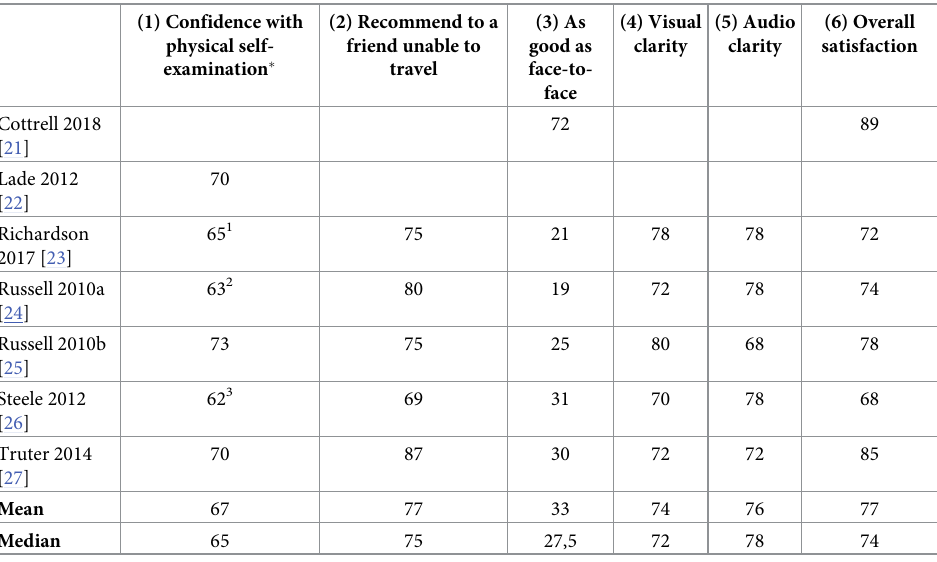
Table 6. Mean values of reported patient satisfaction (VAS 0–100).